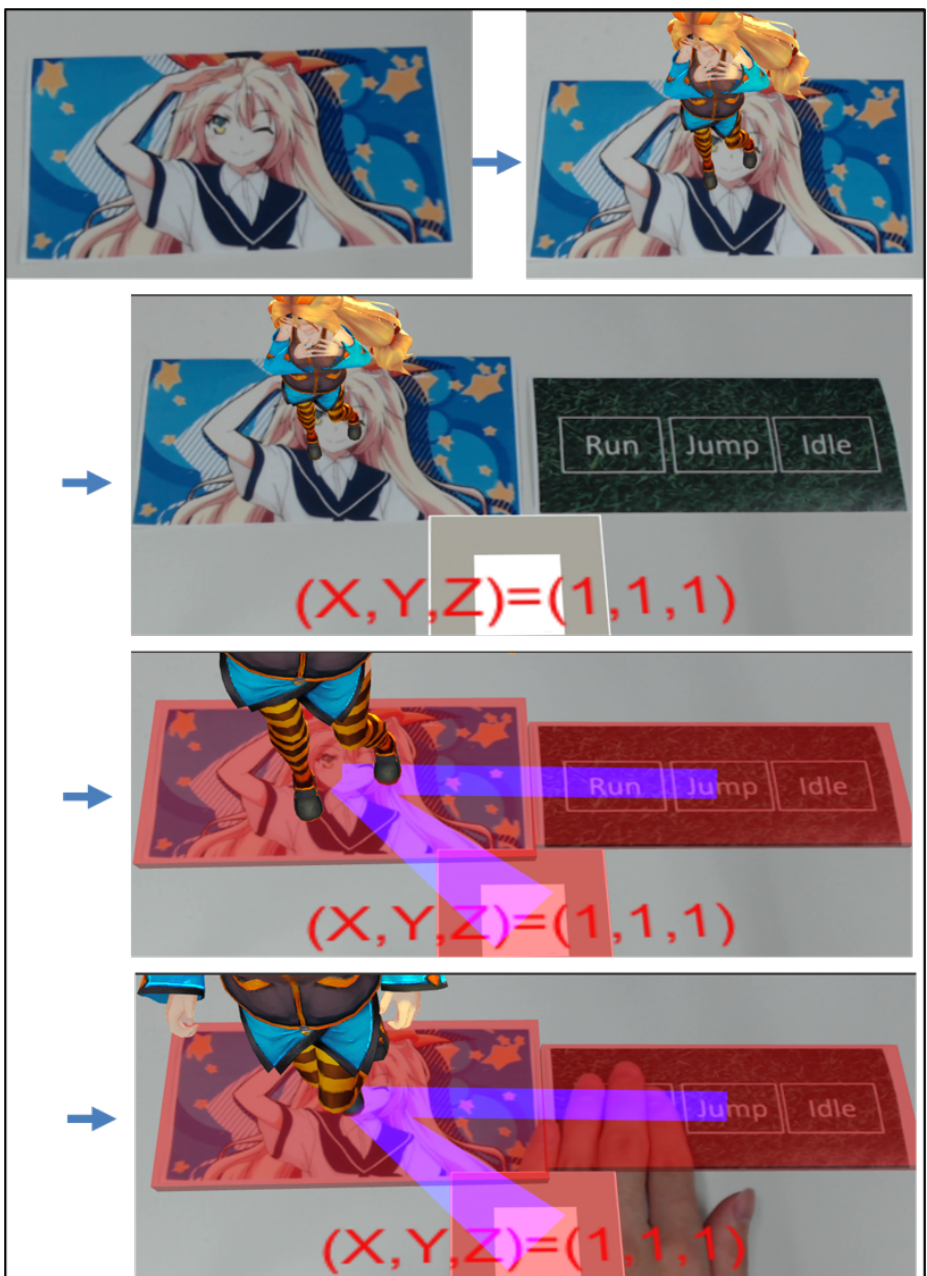
Figure 9. Using markers to control the size and movement of the avatar. The first image shows the avatar marker and the second image shows the avatar being superimposed on the avatar marker. The third picture shows the state of the markers before they are connected. After connecting the 3D vector marker and the avatar marker, the size of the avatar will be set to (1, 1, 1), as shown in the fourth picture. In the fifth picture, the user commands the avatar to run by clicking the control